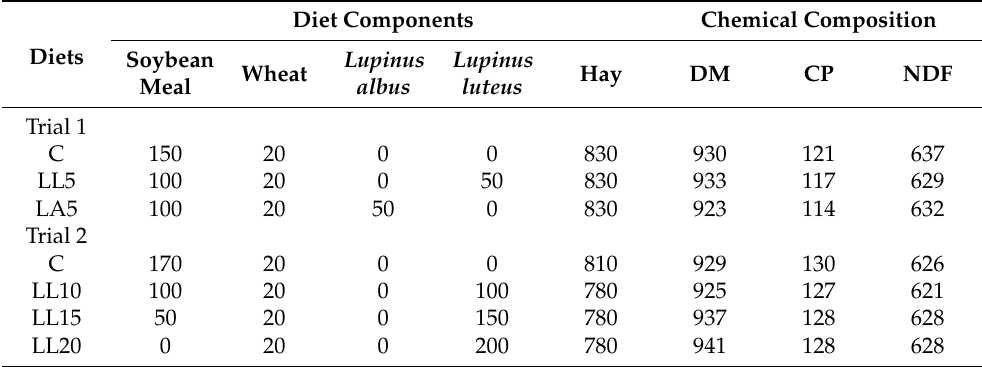
C—Control, LL5— Lupinus luteus 50 g/kg, LA5— Lupinus albus 50 g/kg, LL10— Lupinus luteus 100 g/kg, LL15— Lupinus luteus 150 g/kg, LL20— Lupinus luteus 200 g/kg, DM—Dry Matter, CP—Crude Protein, NDF—Neutral Detergent Fiber.